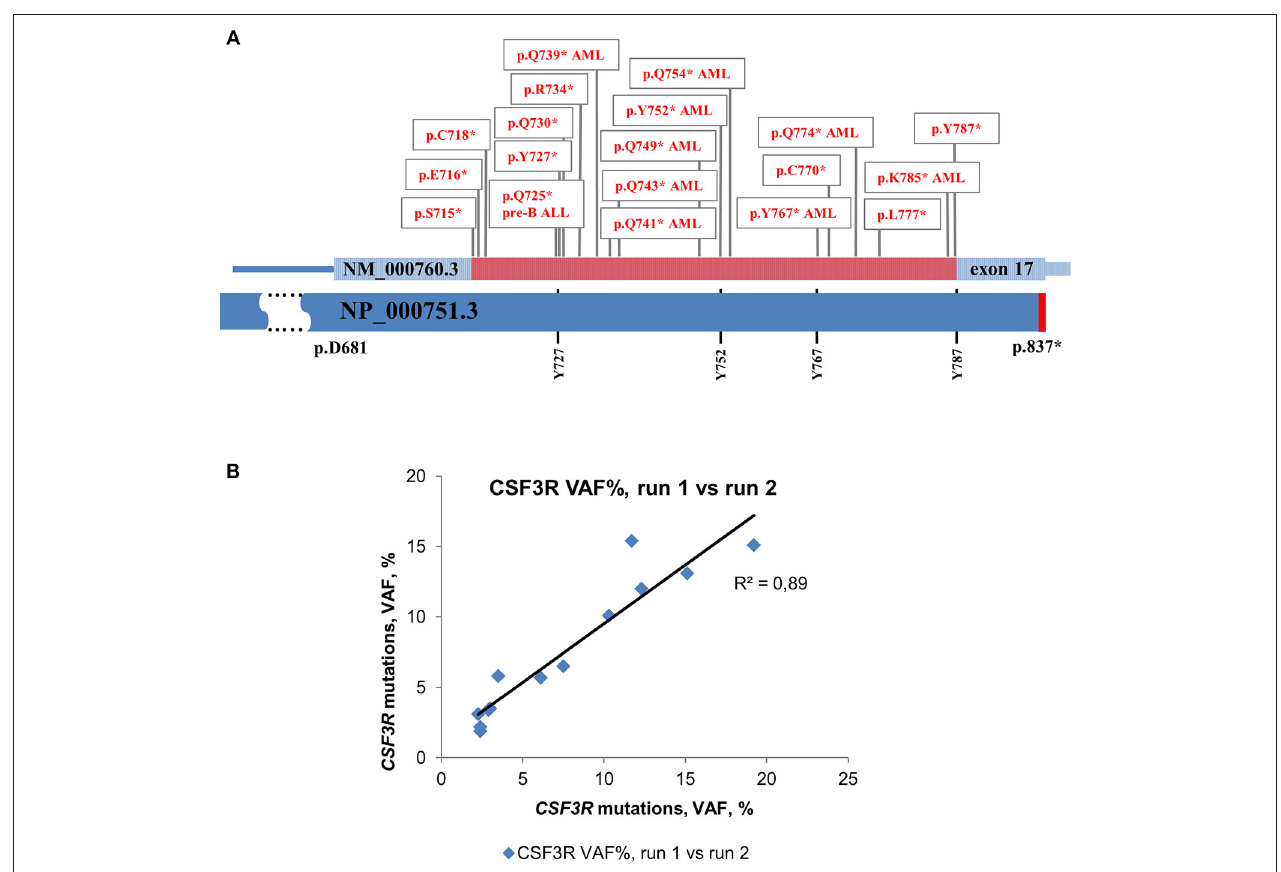
FIGURE 1 | Distribution of acquired mutations in exon 17 of CSF3R in CN and CN-MDS/AML patients. Schematic representation of exon 17 of the CSF3R gene along with protein sequence (NP_000751.3) showing four conserved tyrosine residues. The amino acid positions corresponding to exon 17 are indicated. The intracellular critical region of CSF3R is marked in red. Amino acid (AA) positions of the CSF3R gene mutations are confined to the region between amino acid residues 715 and 787. Mutations in G-CSFR associated with leukemia and MDS in CN are denoted by “AML” or “pre-B ALL”, * - stop codon. (B) Inter-run reproducibility between CSF3R DNA deep sequencing runs. Inter-run reproducibility was assessed by sequencing of 13 CSF3R mutations from 11 CN patients in two separate runs.